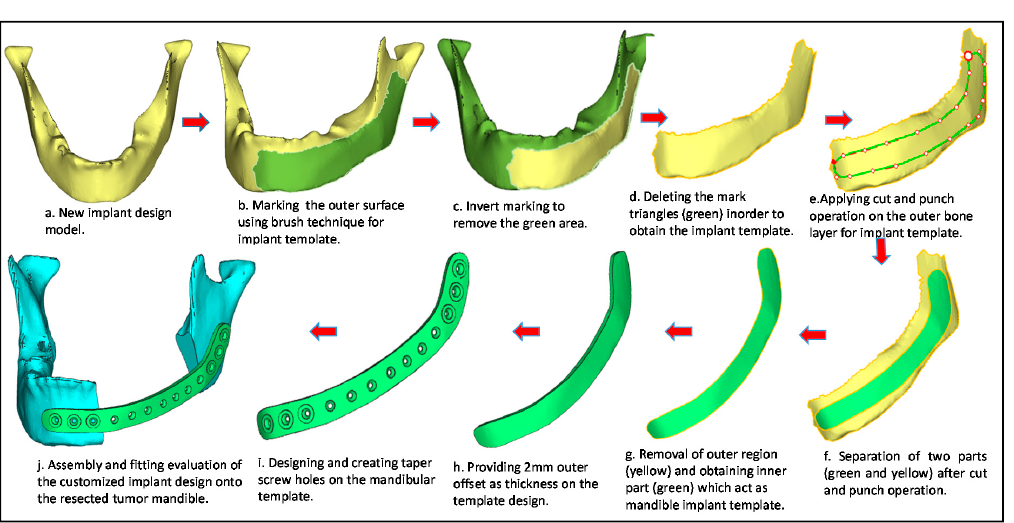
Figure 7. Steps involved in the design of a customized mandibular implant from a healthy design